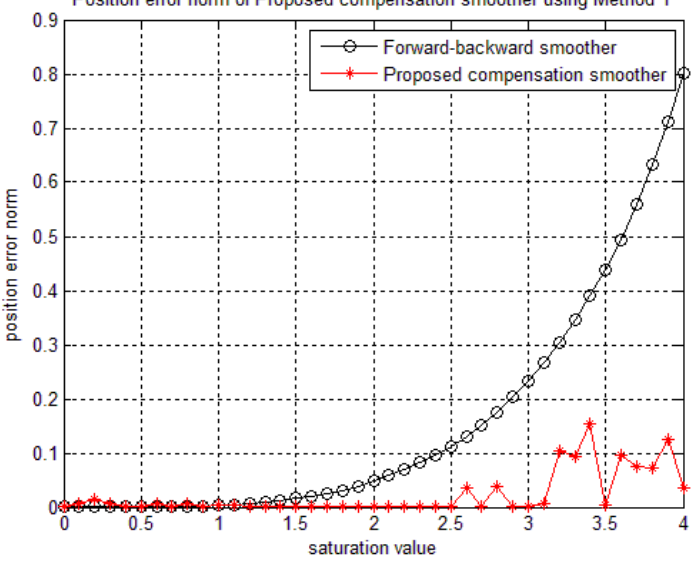
Figure 9. The effect of saturation value (in gyroscope data) on the method 1 smoother